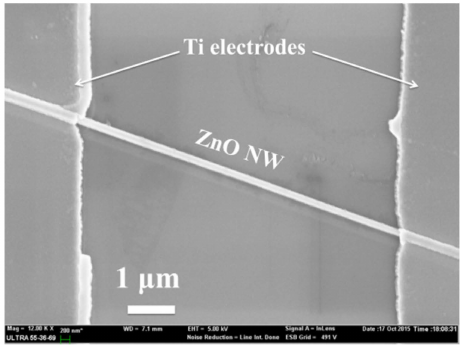
Figure 9. Top-view SEM images of the single ZnO NW–based resistive random access memory (RRAM)